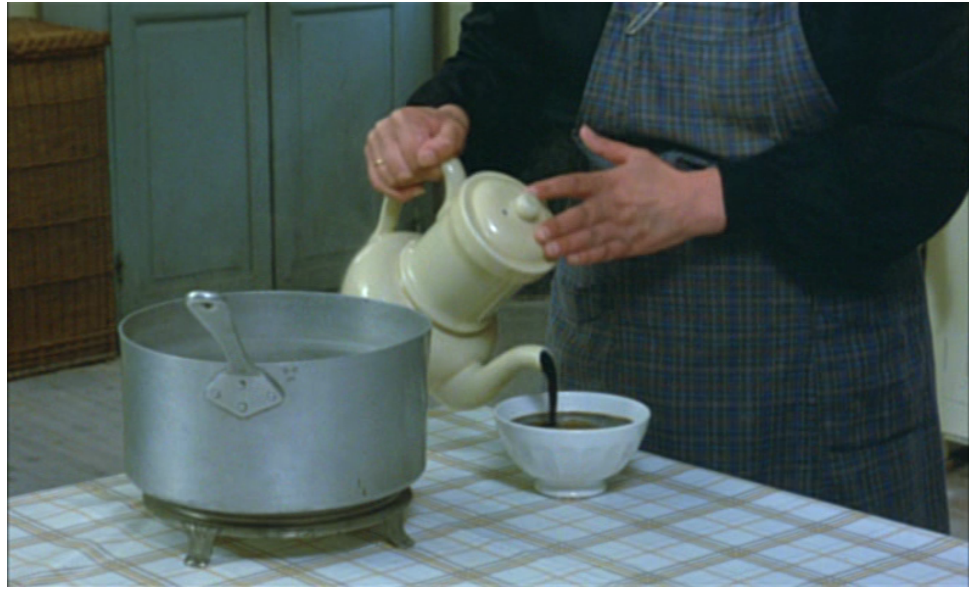
Figure 1: Robert Bresson: still from